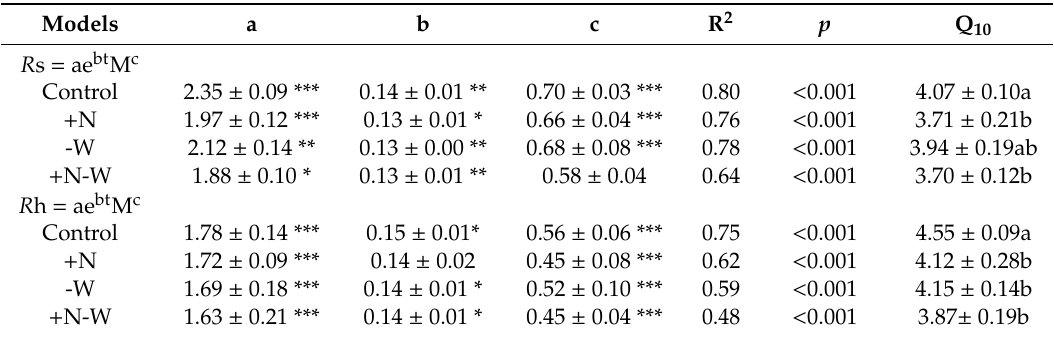
Table 3. Parameter estimates of models for nongrowing season R s and R h as a function of soil temperature (T) and moisture (M) in the 0–5 cm soil from May 2016 to October 2017 in di ff erent treatments (mean ±